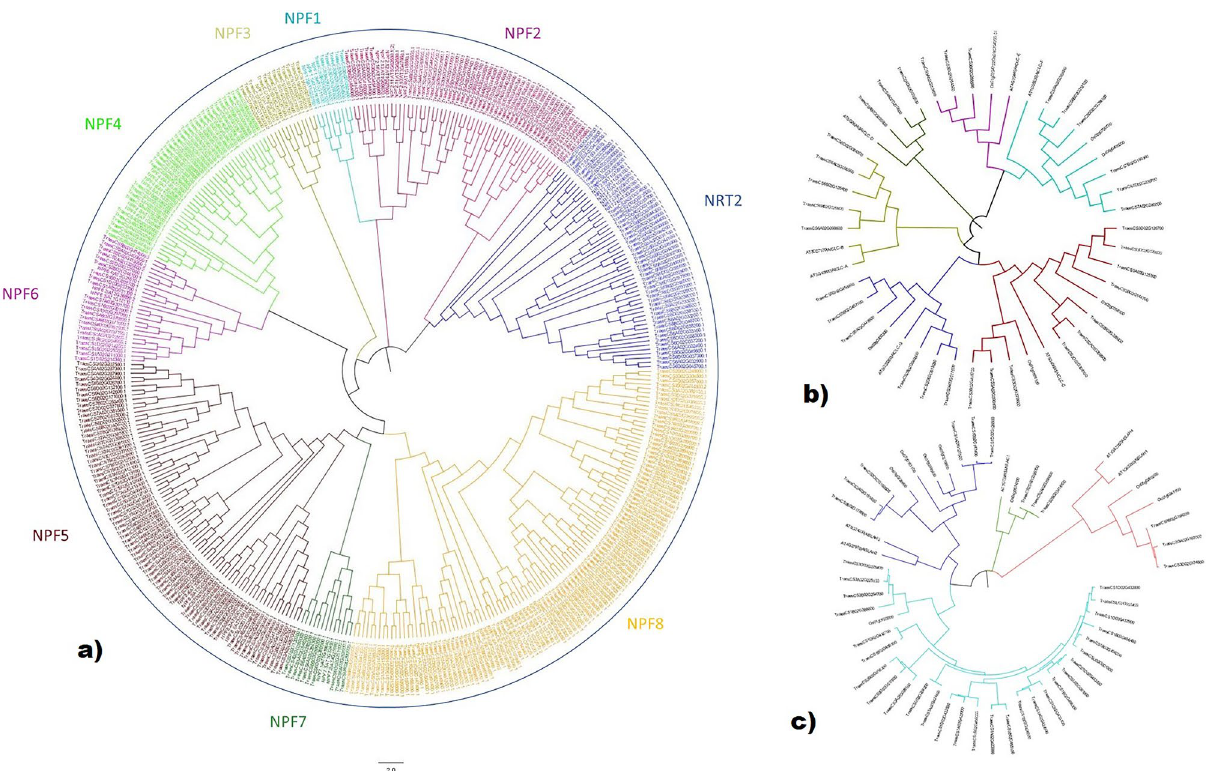
Figure 2. Phylogenetic tree depicting relationship between ( a ) TaNPF and TaNRT2 genes in hexaploid wheat and Arabidopsis thaliana ( b ) TaCLC genes in wheat, rice and Arabidopsis thaliana ( c ) TaSLAC1/SLAH genes in hexaploid wheat, rice and Arabidopsis thaliana. Phylogenetic analysis was performed by MEGA X software 45 and the results were edited and visualized by FIGTREE software v1.4.4. (http:// tree. bio. ed. ac. uk/ softw are/ figtr ee/) to generate final